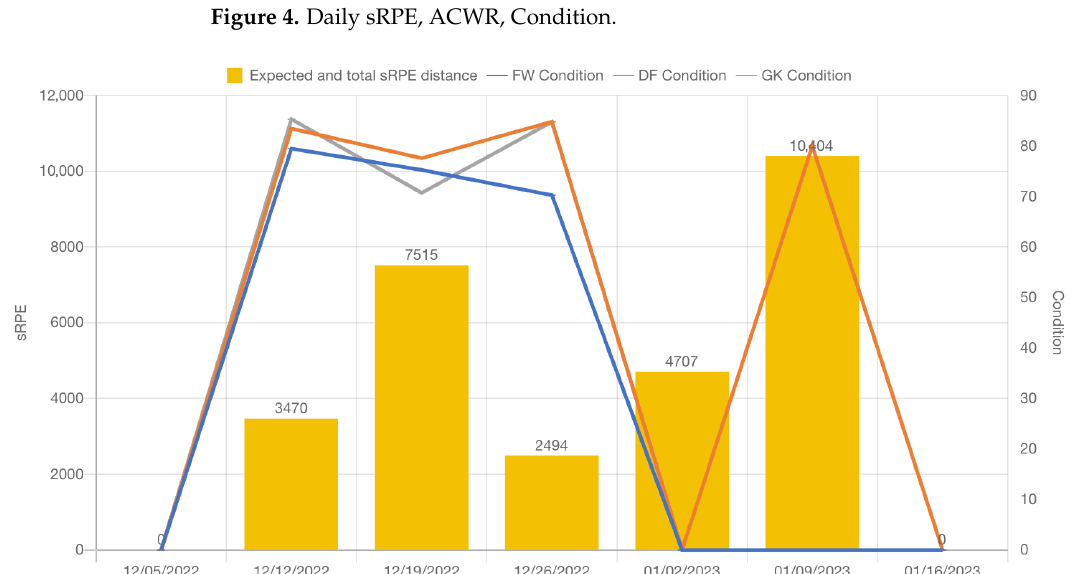
Figure 4. Daily sRPE, ACWR, Condition.